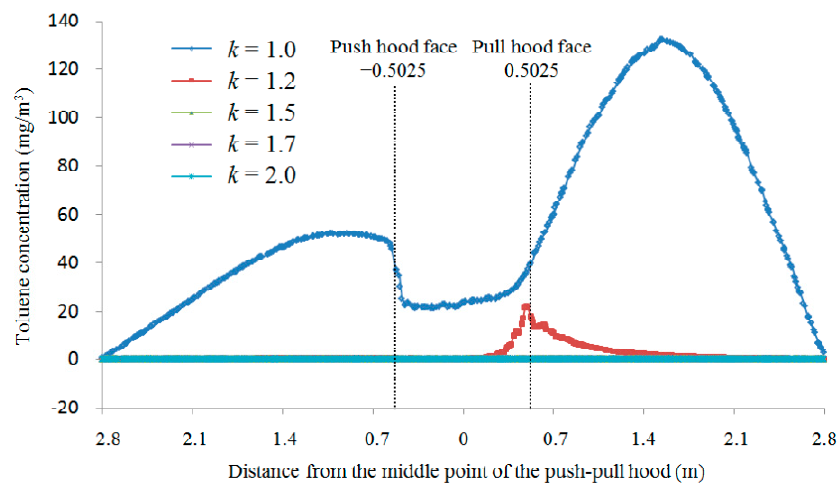
Figure 3. Toluene concentration at respiratory zone locations for different k values at L / a = 1.5. The data lines of k = 1.5, 1.7, and 2.0 overlap.